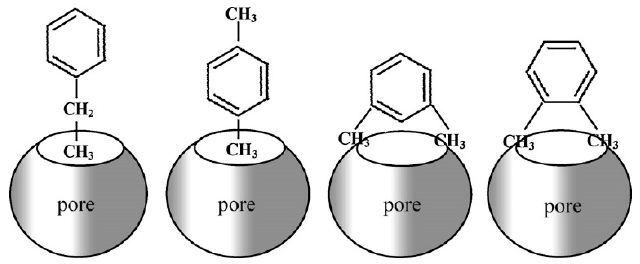
Figure 5. Scheme of ethyl benzene, p -xylene, o -xylene and m -xylene entering into MIL-101 pores. Reprinted from Ref. [73], with permission from